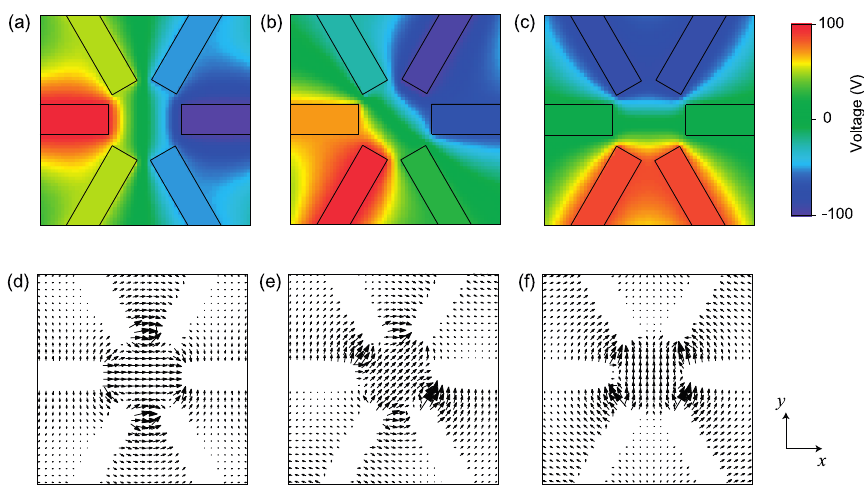
Figure 6. Snapshots of calculated potential in the NLC defect layer obtained by applying three-phase AC voltage: ( a ) Phase A = 0°, ( b ) Phase A = 45°, and ( c ) Phase A = 90°. Calculated electric field vectors at ( d ) Phase A = 0°, ( e ) Phase A = 45°, and ( f ) Phase A = 90°.